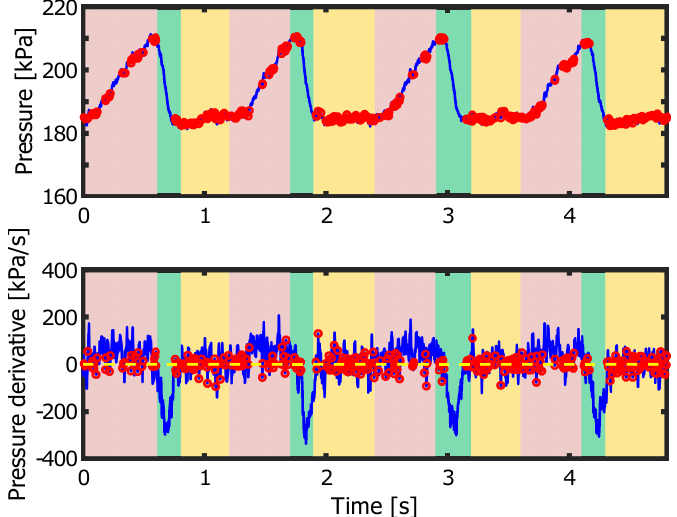
Figure 11. Sample data of the pressure and the pressure derivative for checking Equation (7). The horizontal axis shows time (s), and walking phases are distinguished by color areas. Red areas represent the stance phase, green areas represent the pre-swing phase, and yellow areas represent the swing phase. The ( upper ) figure shows the pressure in the RCB PARM. The ( lower ) figure shows the pressure derivative in the RCB PARM, and blue solid lines and yellow dashed lines are calculated value and the threshold 0 kPa/s. Red circle markers are detected time step k 1